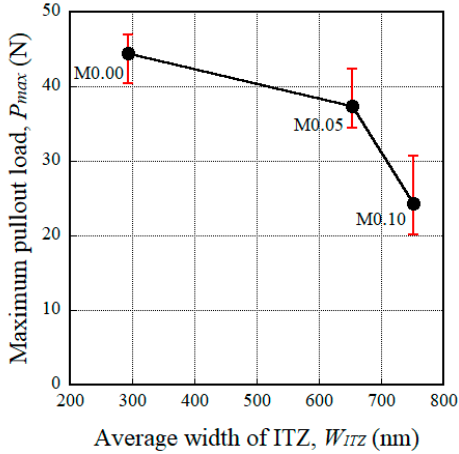
Figure 12. Effect of the width of the ITZ on the maximum pullout load.